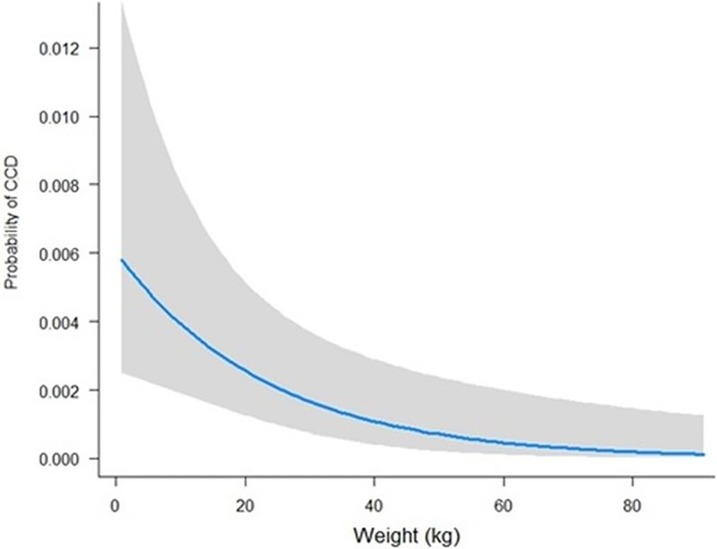
Probability of being affected by canine cognitive dysfunction (CCD) across weight (kg) in the control population.N.B. Age is kept constant (8 years old) to examine the effect of weight in isolation.